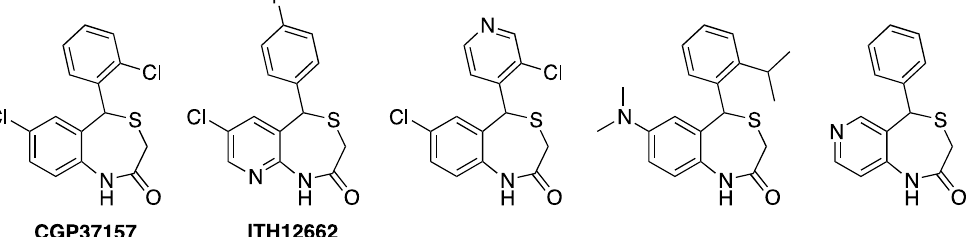
Figure 3. Chemical structures of CGP37157 (first left) and selected third generation analogues with improved pharmacokinetic properties [113,114].